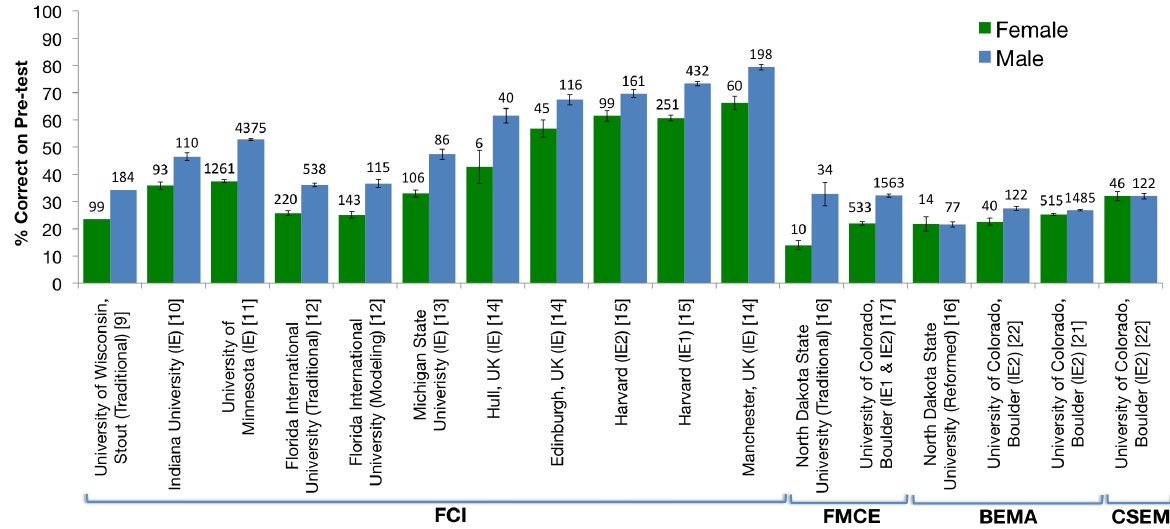
FIG. 1 (color online). Pretest scores for men and women across several institutions on the FCI, FMCE, BEMA, and CSEM. Pretest gender gap on the FCI is usually about 10% across intuitions, instructors, countries, etc. Numbers above bars indicate number of men and women included in the study at each institution. Error bars represent the standard error. If error bars are not present, they were not reported in the study. Instructional methods used in each course are given in parentheses (although these should not influence pretest scores, they are included here to make comparisons with subsequent figures easier). IE is interactive engagement. IE1 and IE2 are different levels of interactive engagement, defined as partially interactive and fully interactive, respectively [17]. This graph does not include CSEM data from Ref. [28], which reported only gender gaps and not